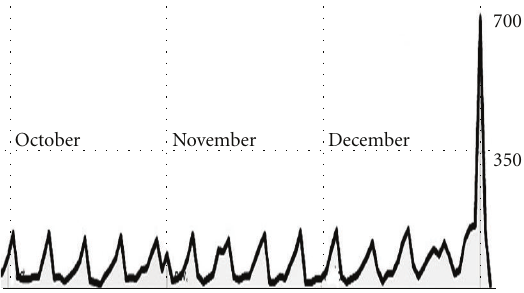
Figure 1: Number of visitsona French website for alcoholhangover (http://gueuledebois.info/). Data are shown from October 1st 2011 to January 2nd 2012. Each peak corresponds to a Sunday. Note the large peak at New Years day. The peak at November 1st corresponds to the day after Halloween (31 October). Data were obtained via Google Analytics.